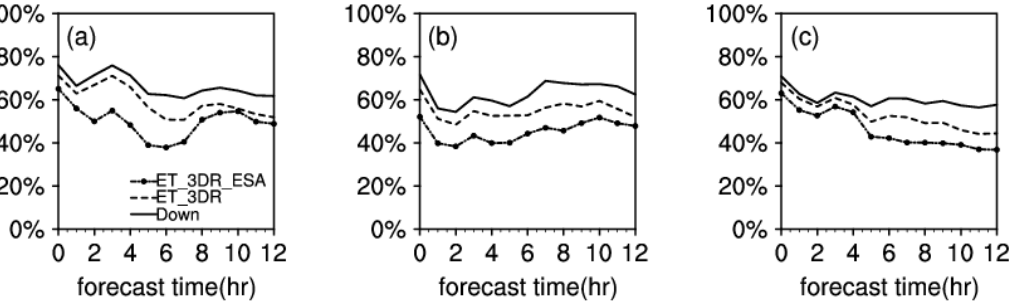
Figure 6. Percentage of outliers for the three ensemble forecast systems under 500-hPa conditions; ( a ) temperature T (unit: K), ( b ) zonal wind U (unit: m/s), and ( c ) radial wind V (unit: m/s).